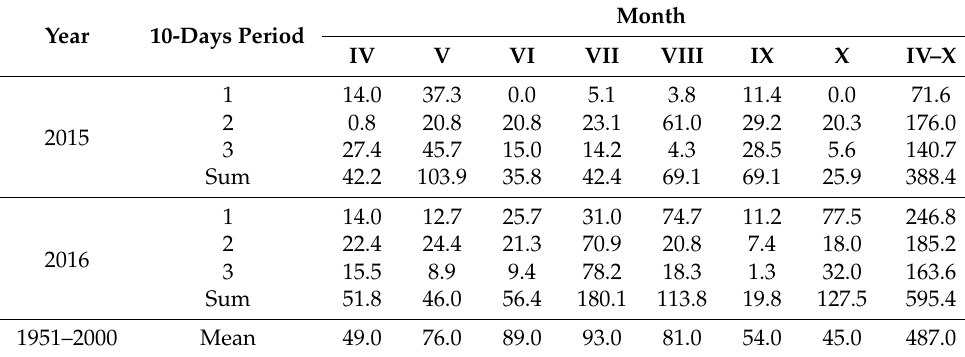
Table 2. Sum and mean precipitation (mm) for 10-days periods, months, and growing seasons in